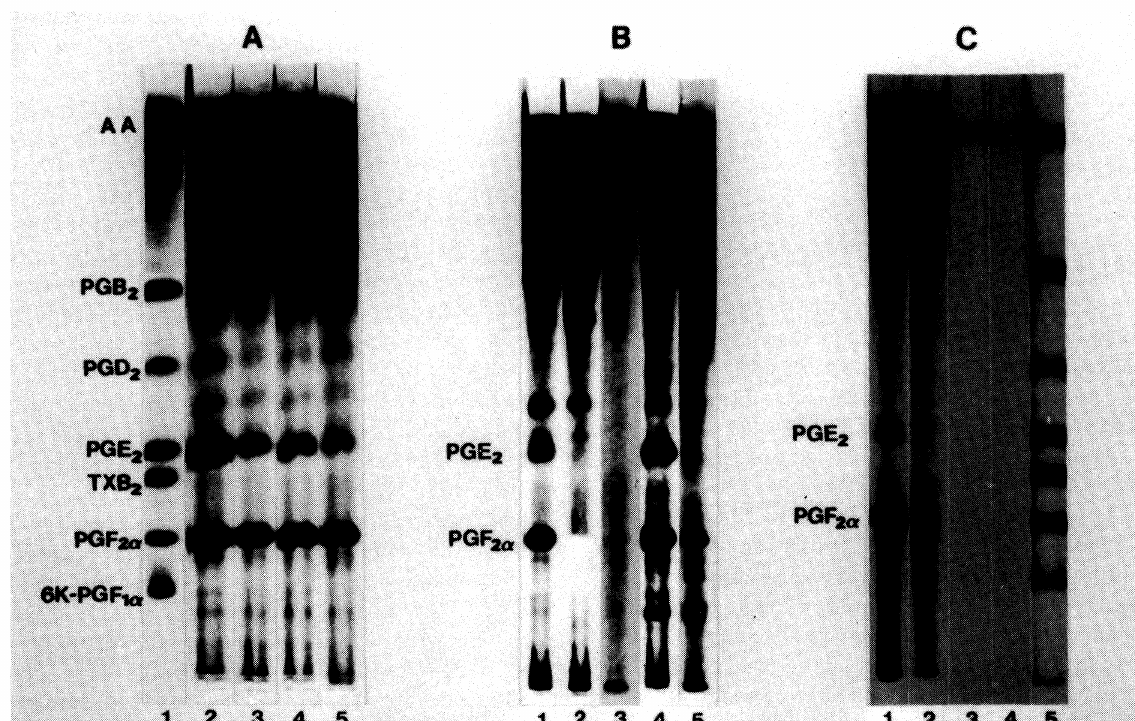
FIG. 1. (A) Autoradiograph of a TLC plate demonstrates the effect of hPTH-(1-34) and other additives on the conversion oT arachidonic acid (AA) to prostanoids by chick calvarial homogenates. Lane prostanoid standards. Lane 2: hPTH-(1-34) (0.6 #g/ml 1.4 x 10 M). Lane 3: EGF (20/g/ml). Lane 4: PDGF (20mU/ml). Lane 5: control. (B) Autoradiograph of a TLC plate demonstrates that the effect of blocking agents and effectors on PTH-induced synthesis of prostanoids by chick calvarial homogenates. Lane hPTH-(1-34) (0.6 #g/ml) + cycloheximide (10 #M). Lane 2: hPTH-(1-34) (0.6#g/ml)+actinomycin (5#M). Lane 3: hPTH-(1-34) (0.6#g/ml)+indomethacin (5 x 10-rM). Lane 4: hPTH-(1-34) (0.6#g/ml) + stannous chloride (1.9 mg/ml). Lane 5: ionophore A23187 (10#M). (C) Autoradiograph of a TLC plate demonstrates that PG synthase activity stimulated by hPTH-(1-34) can only be recovered in the microsomal fraction of chick calvaria. Lane 1: hPTH-(1-34) (0.6 #g/ml), microsomal fraction. Lane 2: control, microsomal fraction. Lane 3: hPTH-(1-34) (0.6 #g/ml), cytosol fraction. Lane 4: control, cytosol fraction. Lane 5: prostanoid